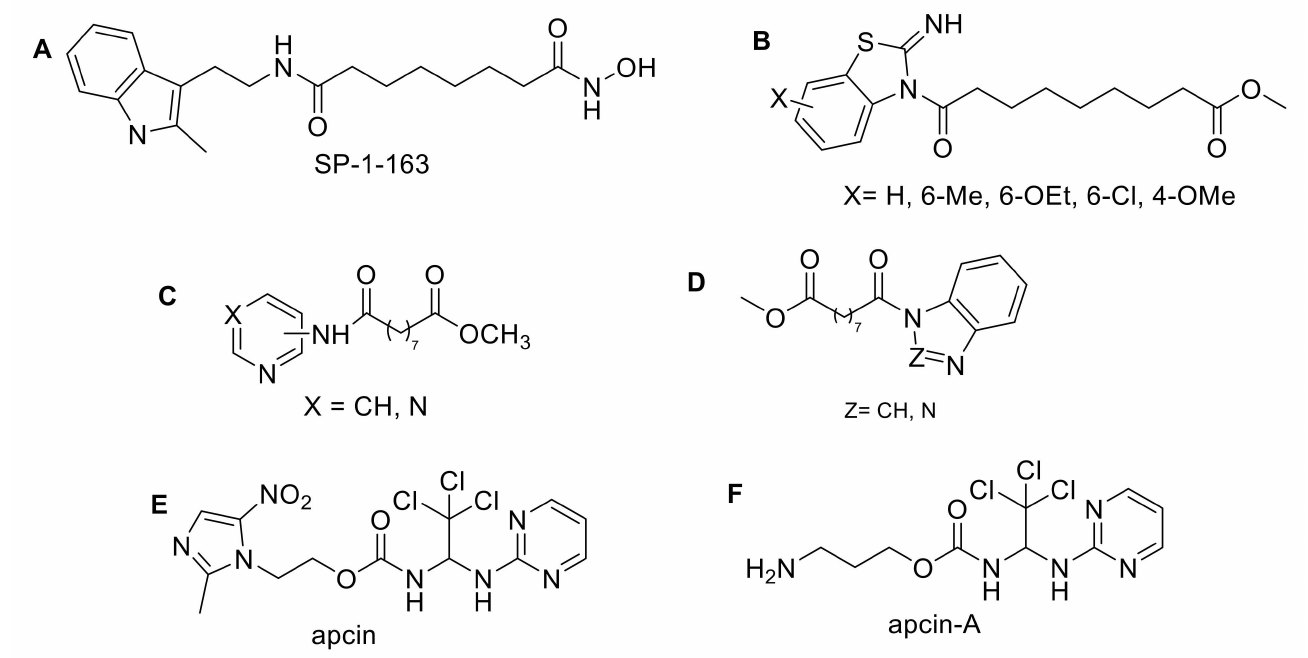
Figure 2. Biologically active compounds bearing ( A ) indole-, ( B ) thiazole-, ( D ) triazole-, ( C ) pyridinyl- and ( E , F )